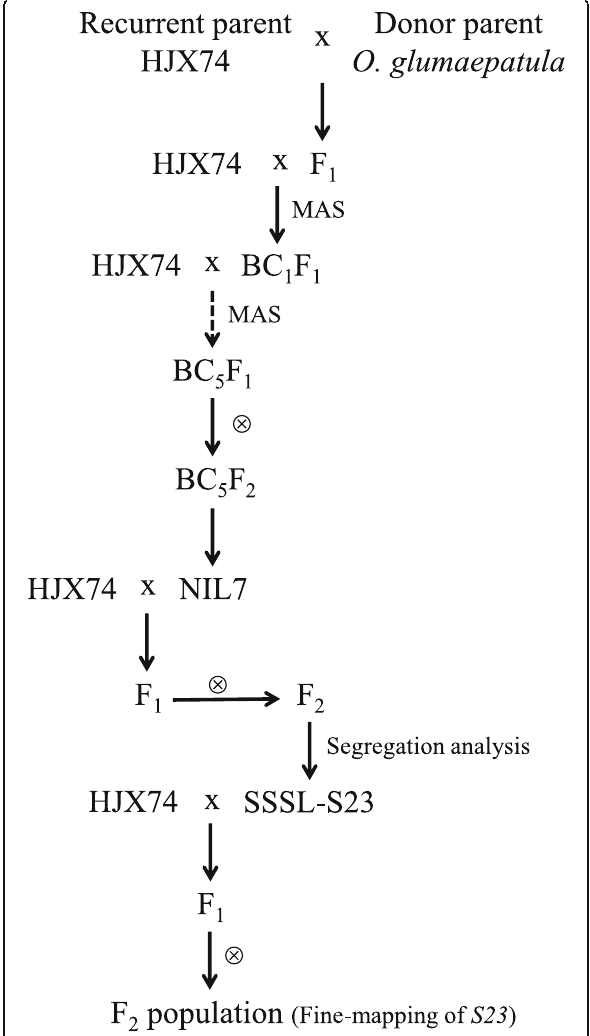
Fig. 1 Flowchart of the development and analysis of SSSL-S23. MAS: marker-assisted selection